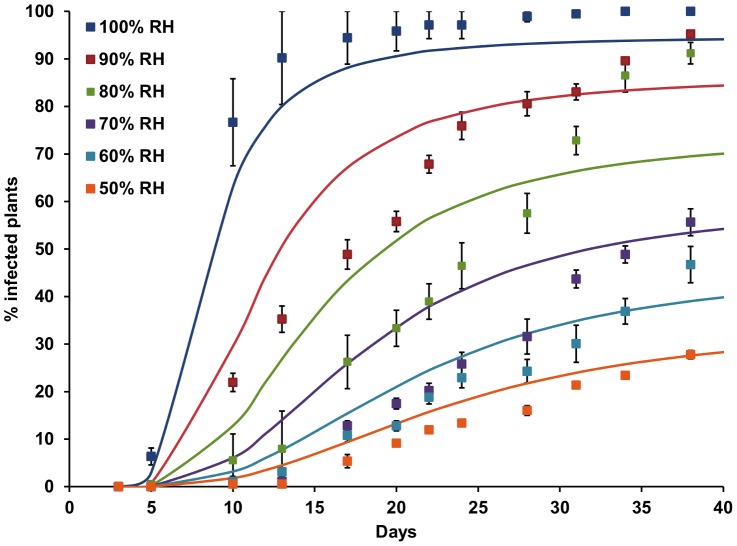
Effect of relative humidity (RH) on S. sclerotiorum disease development in lettuce at 20°C.Points represent observed data, lines represent fitted functions. Error bars are the standard error of the mean (three replicates).